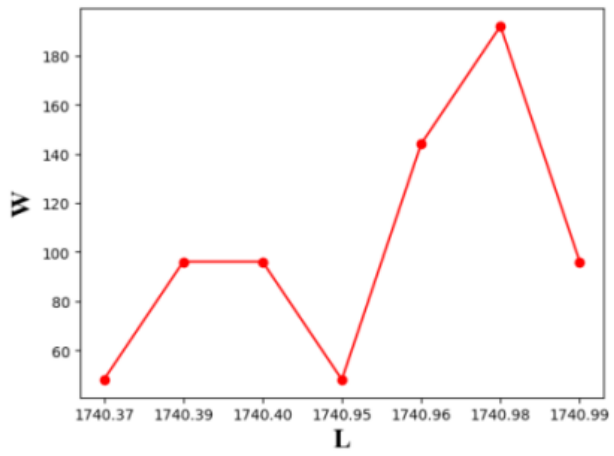
Figure 20. The influence of different placement sequences of heterogeneous transmitter on the length of BR barrier (We use 6 types of transmitters, one for each type, and test on 720 heterogeneous BR placement sequences).